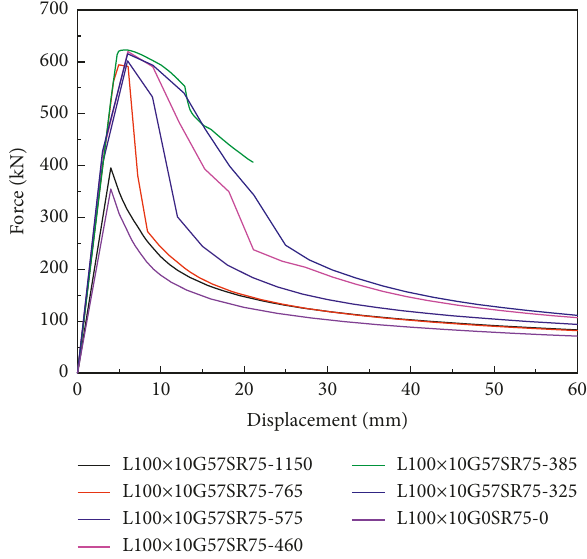
Figure 7: Force-displacement curve (L100 ×